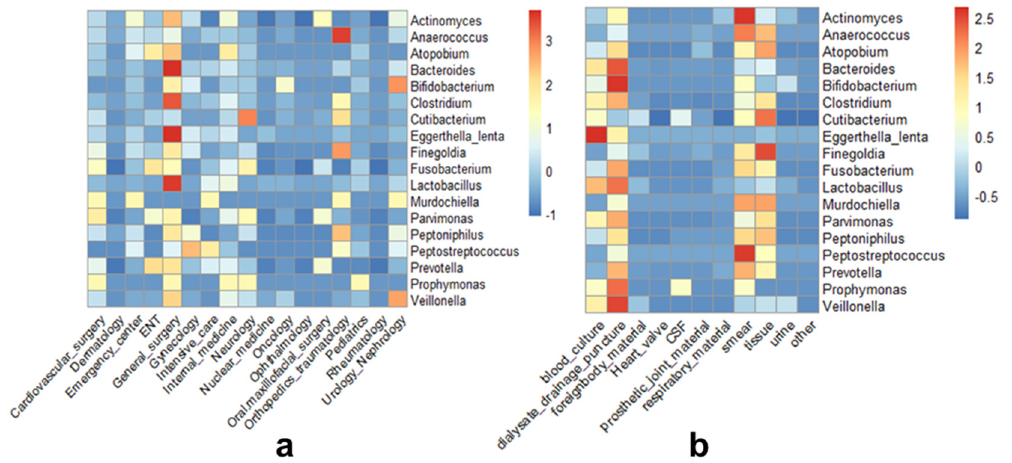
Figure 1. Heatmap of the isolate number of anaerobic bacteria distributed across ( a ) wards or ( b ) samples. The color represents normalized Z-score value where higher scores indicate higher number of isolates.